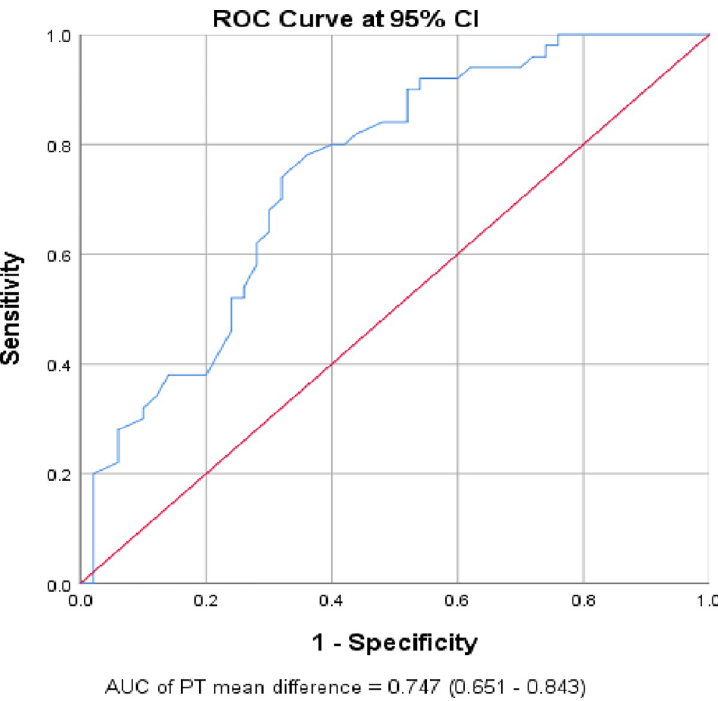
Fig 3. The ROC curve of the gradual change of prothrombin time over the 7th days for the prediction of good prognosis of COVID-19 patients (n = 100).